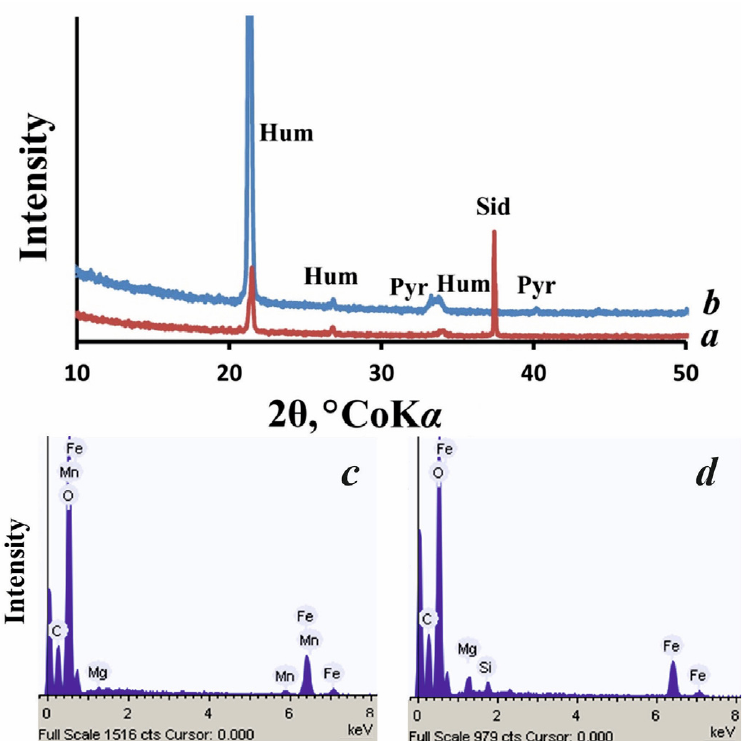
Figure 1. Identification of humboldtine according to PXRD ( a , b ) and EDX spectra ( c , d ): ( a )—X-ray pattern of humboldtine on siderite (5 days), ( b )—X-ray pattern of humboldtine on pyrrhotite (7 days), ( c )—EDX spectra of humboldtine on siderite, ( d )—EDX spectra of humboldtine on pyrrhotite. Hum— humboldtine, Sid—siderite,